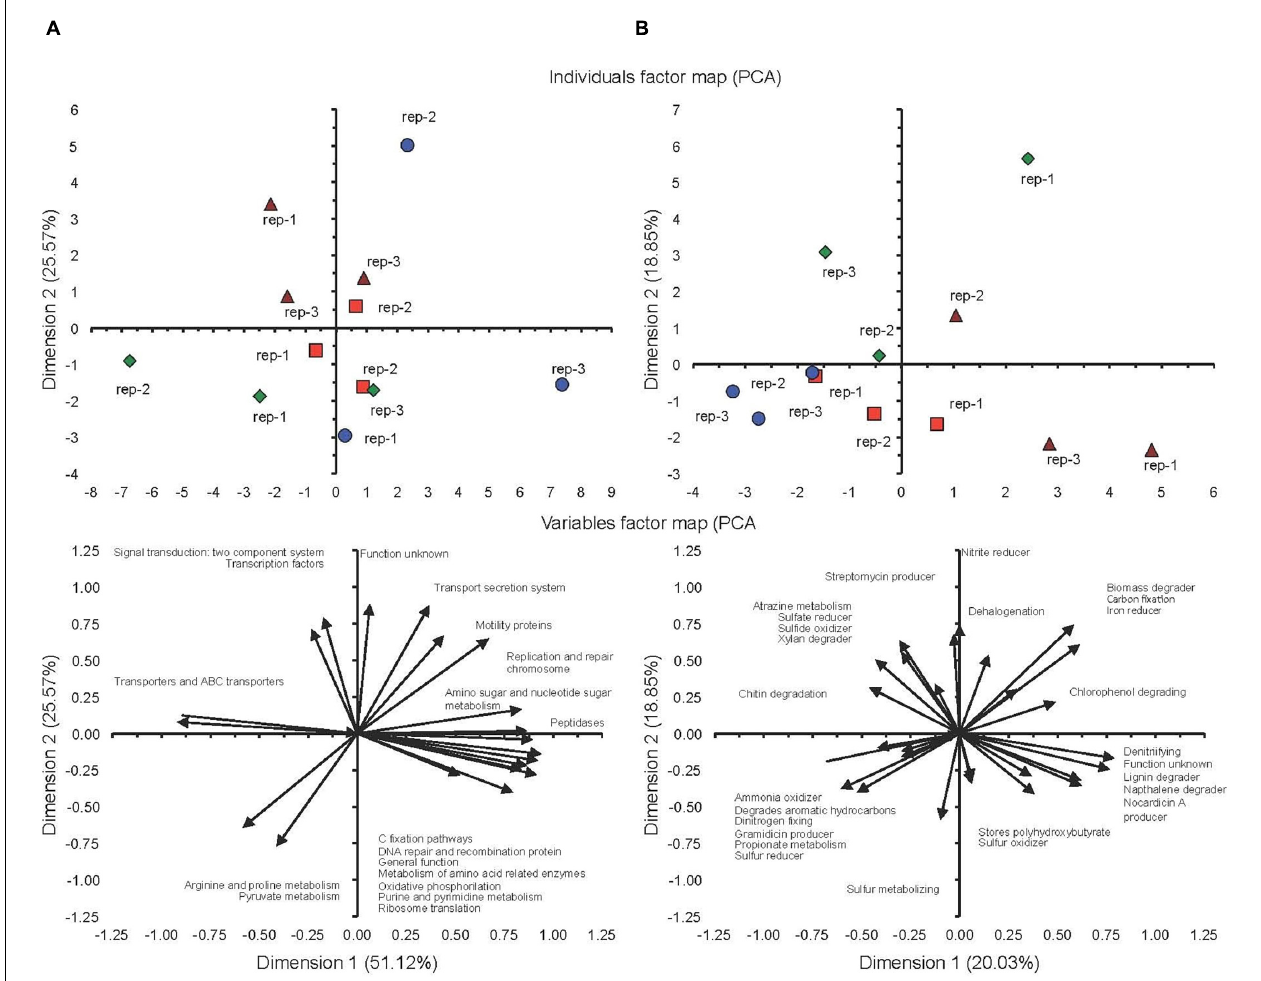
FIGURE 6 | (A) Principal component analysis with the KEGG orthologs metabolic functions. (B) The METAGENassist metabolic functions in soil cultivated conventionally incubated at 5% of field capacity ( ) or field capacity ( ) or milpa soil incubated at 5% of field capacity ( ) or field capacity ( ) incubated aerobically for 45